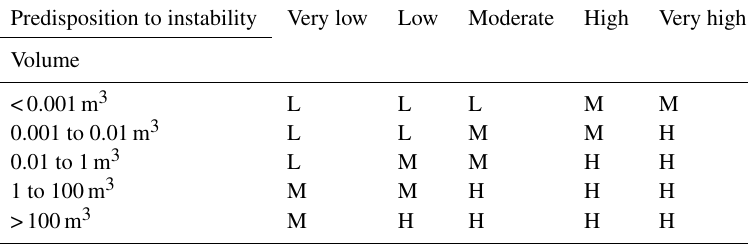
Table 5. Assessment of the rockfall hazard with the LPC method. Predisposition to instability